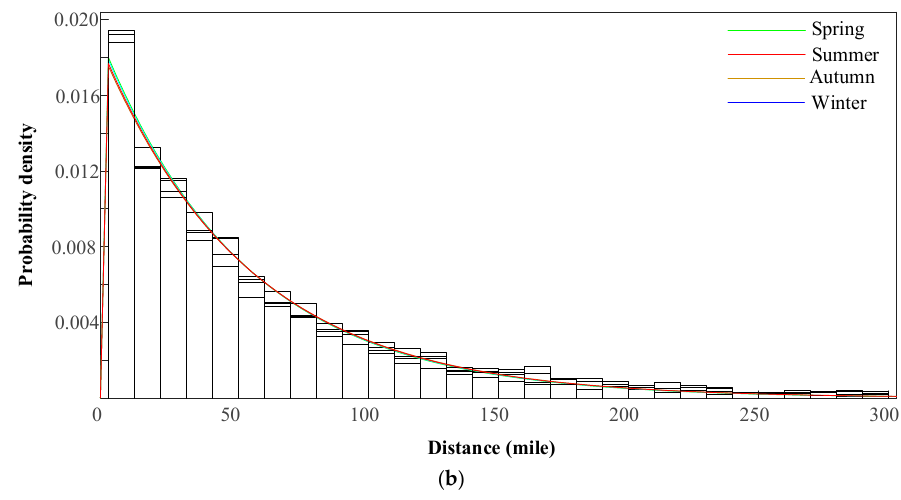
Figure 2. Probability distribution of domestic users’ daily travelling distance per vehicle (in miles); ( a ) For one year; ( b ) For different seasons.